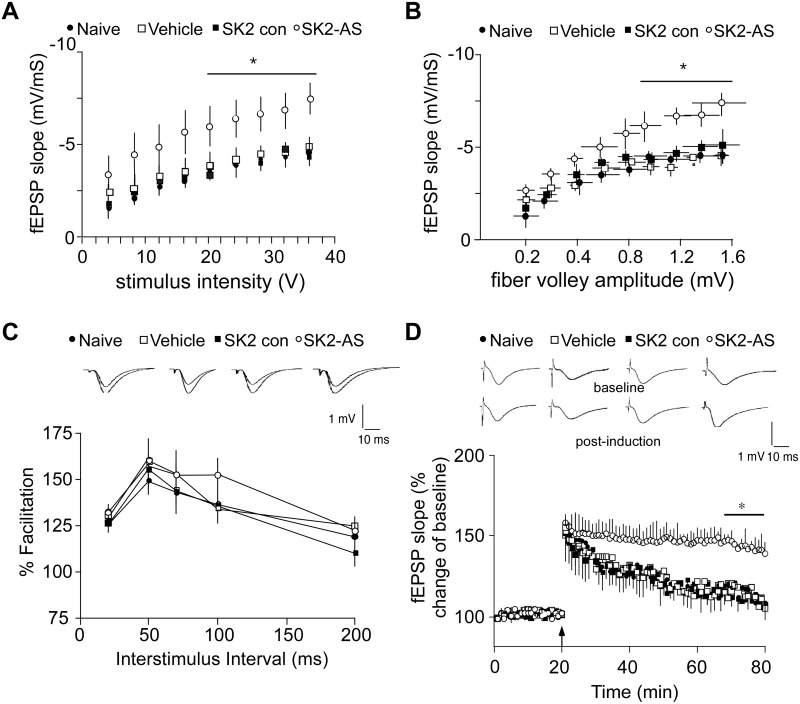
Enhanced basal synaptic transmission and LTP in hippocampal slices from mice pre-treated with SK2 antisense ODNs.The distance between the stimulating and recording electrodes was kept constant between slices. (A) Input-output curve of fEPSP slope (mV/ms) versus stimulus (V) at the SC-CA1 pyramidal cell synapse in naive mice and mice pre-treated with vehicle, antisense ODNs against SK2 channels and control ODNs. The maximal fEPSP slopes were significantly larger in the SK2 antisense-treated mice than those in the naive, vehicle and control ODNs-treated mice. Data are presented as mean ± s.e.m. (B) Relationship between the slope of the evoked fEPSPs from panel A and the corresponding fiber volley amplitude. SK2 antisense-treated mice exhibit a greater postsynaptic response than control groups to similar presynaptic depolarization. Data are presented as mean ± s.e.m. (C) Comparison of PPF in naive mice and mice pre-treated with vehicle, antisense ODNs against SK2 channels and control ODNs. No differences were found between these four groups of mice. Data presented are the mean ± SEM of the facilitation of the second response relative to the first response. Insets: Field EPSPs recorded in response to paired-pulse stimulation at an interstimulus interval of 50 ms in slices from all four treatment groups as indicated. (D) TBS-LTP elicited in slices from mice that were pre-treated with SK2 antisense ODNs was significantly enhanced when compared to LTP induced in slices from naive mice. There was no statistical difference between control ODNs-injected mice and mice that were pre-injected with vehicle. Insets: Responses shown are fEPSPs recorded during baseline (upper row) and 55–60 min (bottom row) after the induction of LTP (post-induction). Traces are averages of five consecutive responses. Statistical significance was determined by two-way ANOVA followed by Bonferroni multiple comparisons test (*p < 0.05).